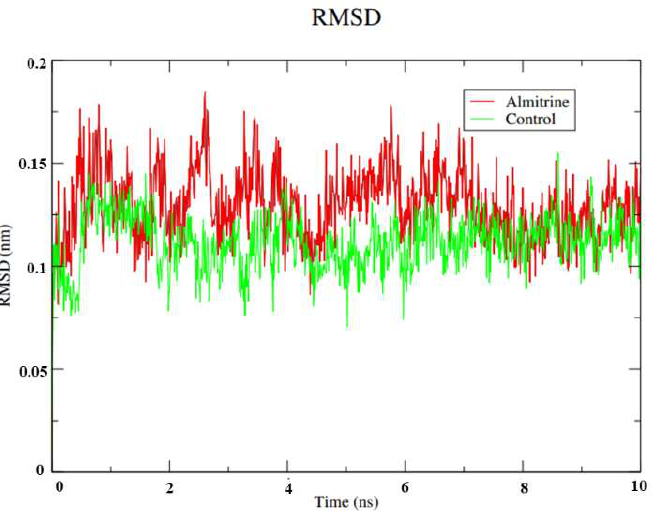
Figure 3. RMSD values of the C α atoms of almitrine and the control (thapsigargine) with the transporting ATPase aplha 1. Legend: Green: ATPase of H. sapiens complexed with thapsigargine; and Red: ATPase of H. sapiens complexed with almitrine .